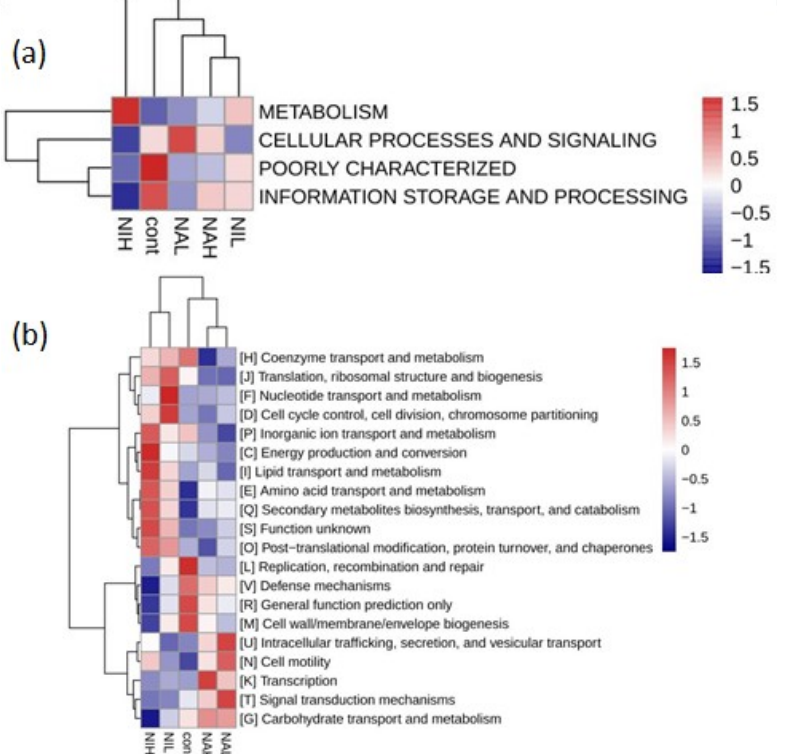
Figure 6. COG abundance clustering heat map at the level 1 ( a ) and level 2 ( b ) in the five treatments. Cont: control; NAH: 1 mg/L sodium selenate); NAL: 100 µ g/L sodium selenate; NIH: 1 mg/L sodium selenite; NIL: 100 µg/L sodium selenite.